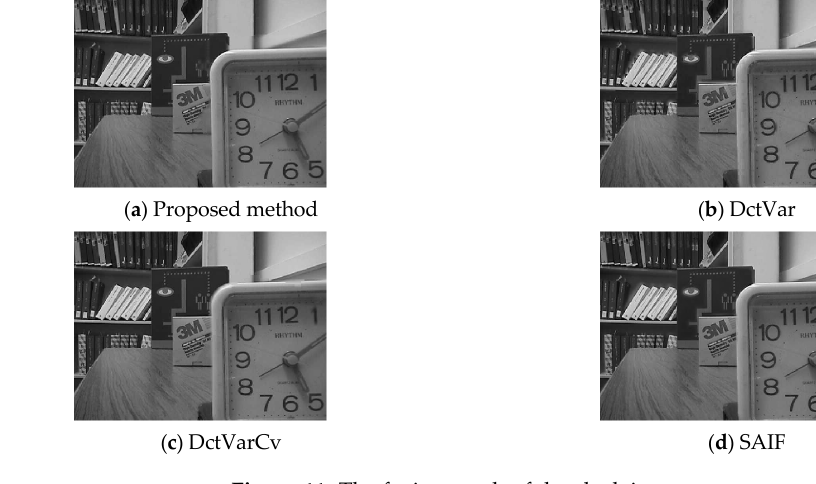
Figure 11. The fusion result of the clock image.